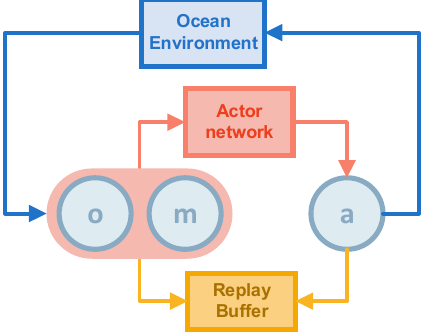
Figure 1. The execution process of MATSMI.